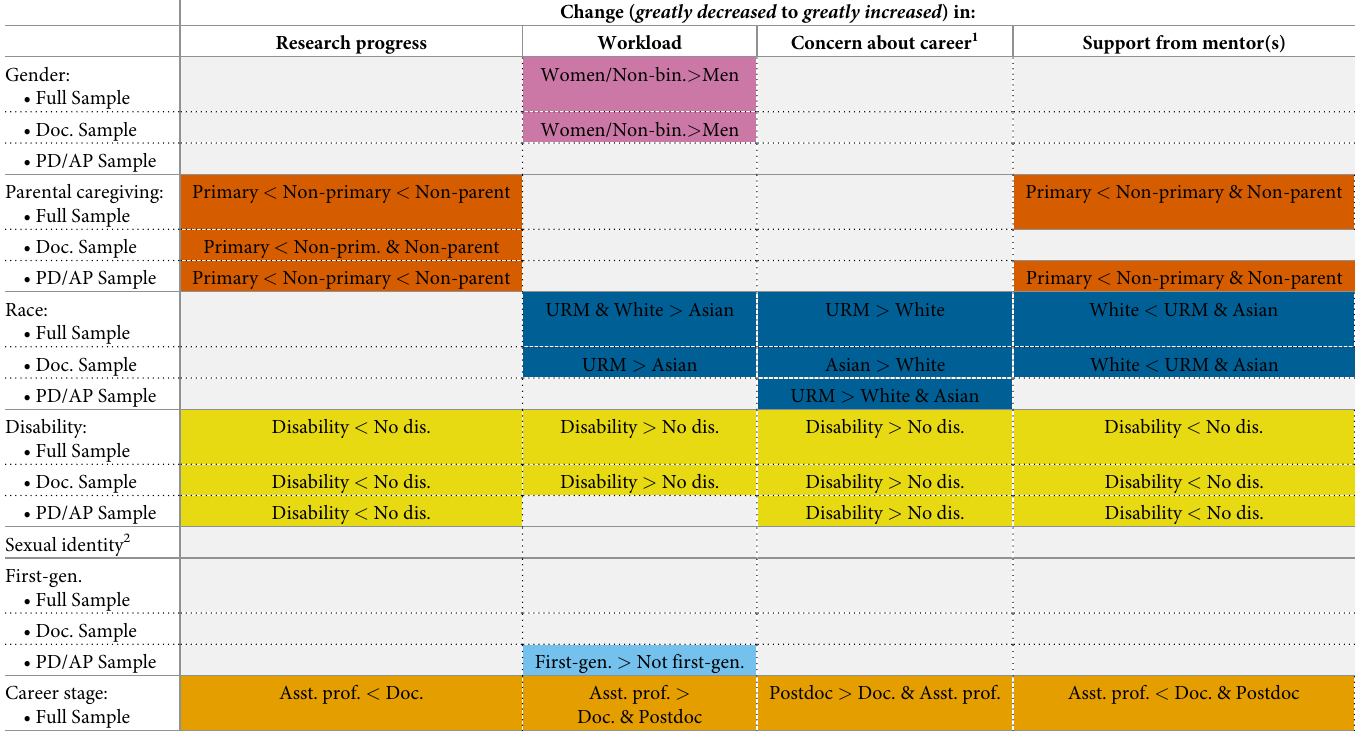
Table 1. Summary of results for all socio-demographic statuses and change in COVID-19 work impacts. Change ( greatly decreased to greatly increased )